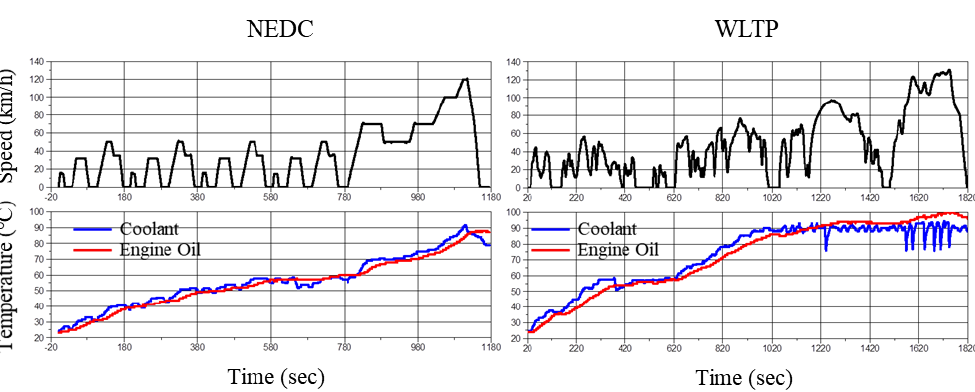
Figure 13. Coolant and engine oil temperature distribution according to the test cycle.